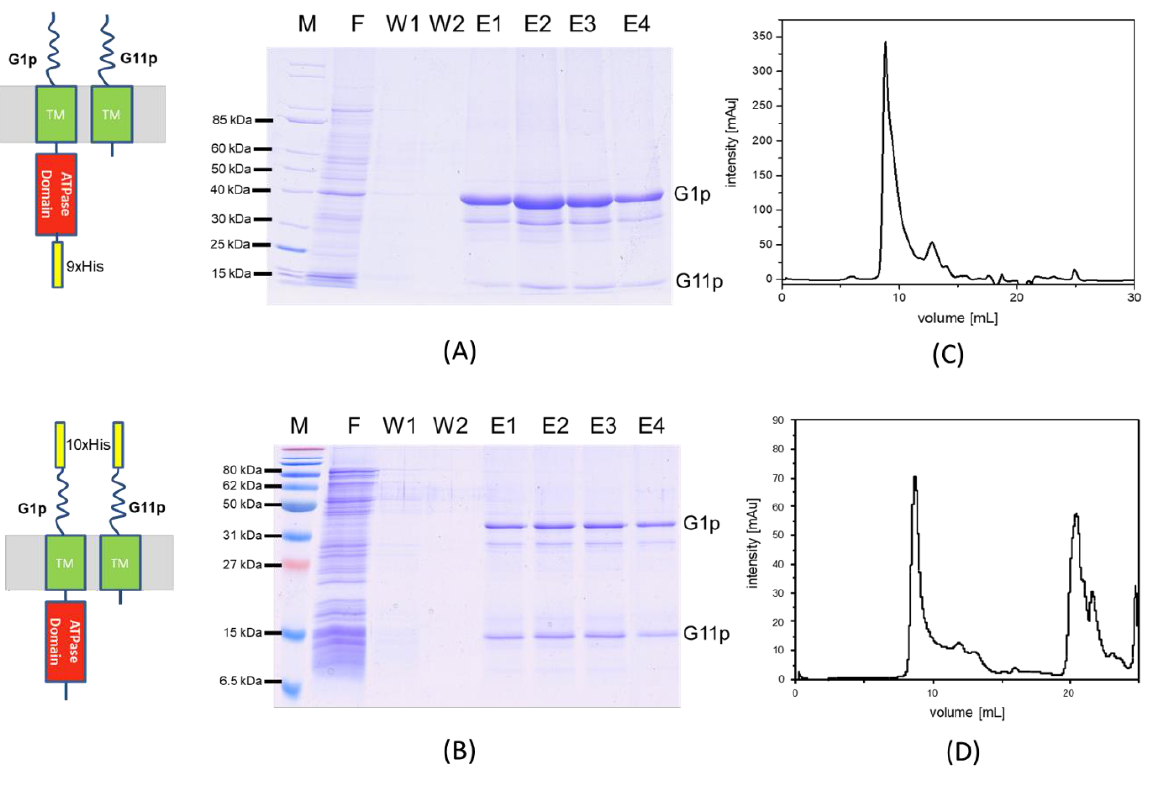
Figure 3. Purification of G1p/G11p by Ni 2+ -affinity chromatography. The HisG1p and G11p elute in the same fractions ( A ), similarly to the C-his construct ( B ) as the Coomassie stained gels show. Size exclusion chromatography with a Superdex 200 10/30 column was used to further purify the N-his complex ( C ) and the C-his complex ( D ). Both purification profiles show a single peak at an elution volume of about 10 mL, corresponding to a molecular weight of 320 kDa. M refers to Marker, F to flow through, W to wash and E to elution fraction.